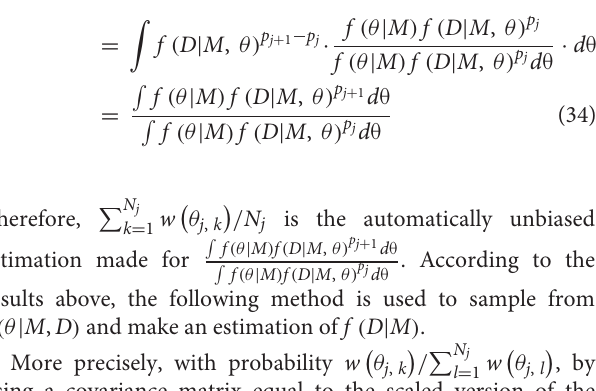
Frontiers in Built Environment |